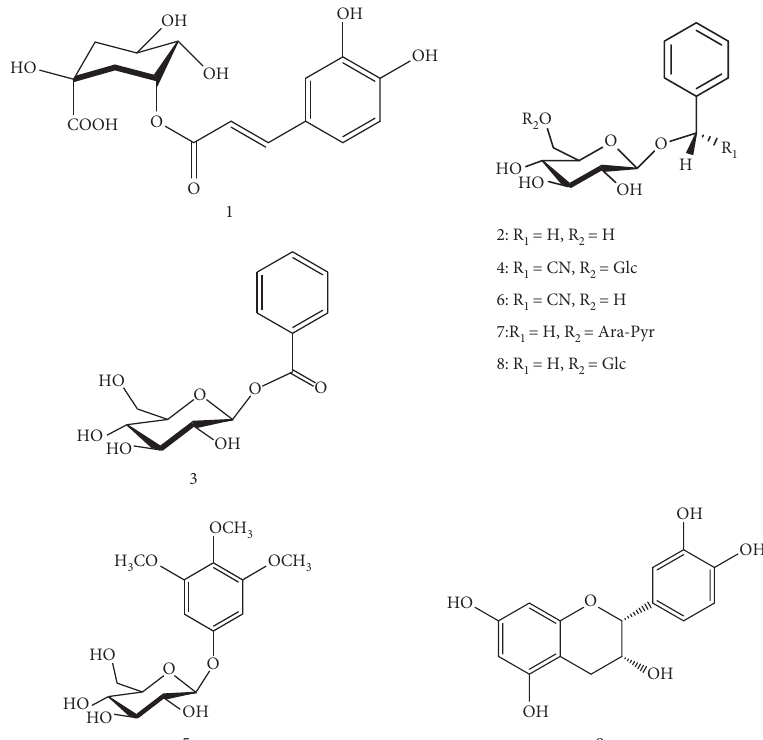
Figure 1: Structures of compounds 1–9 used as reference standards for P. mume fruits: 1, neochlorogenic acid (NCA); 2, benzyl- β -D- glucopyranoside (BGP); 3, β -D-glucopyranosyl benzoate (GPB); 4, amygdalin; 5, 3, 4, 5-trimethoxyphenyl- β -D-glucopyranoside (TMPGP); 6, prunasin; 7, benzyl- α -L-arabinopyranosyl-(1 ⟶ 6)- β -D-glucopyranoside (BAPGP); 8, benzyl- β -D-xylopyranosyl-(1 ⟶ 6)- β -D-glu- copyranoside (BXPGP); 9, ( − )-epicatechin. Table 1: Sample lists of P. mume fruits collected in Korea. Harvest regions ∗ No. of